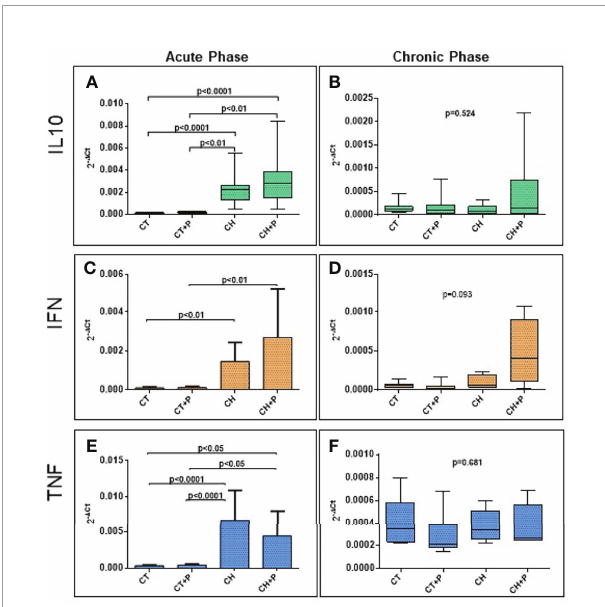
FIGURE 3 | Absolute gene expression of in fl ammatory cytokines. (A) IL10 gene expression in the acute phase (n=49); (B) IL10 gene expression in the chronic phase (n=38). (C) IFN gene expression in the acute phase (n=49); (D) IFN gene expression in the chronic phase (n=38), (E) TNF gene expression in the acute phase (n=49); (F) TNF in the chronic phase (n=38). CT - control group, CT+P – control group exposed to pollution, CH – chagasic group, CH +P – chagasic group exposed to pollution.